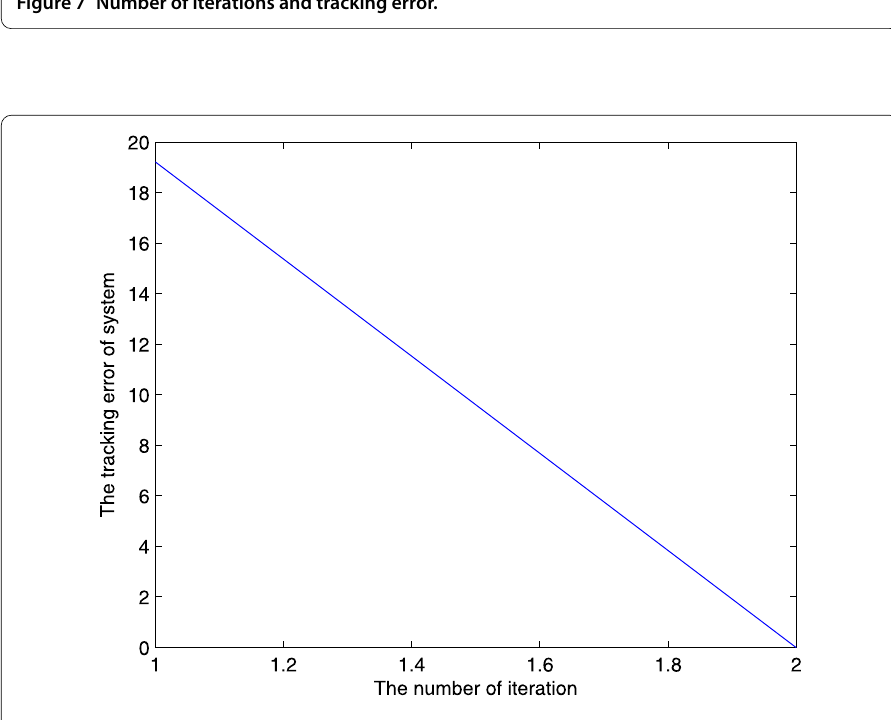
Figure 8 Number of iterations and tracking error.